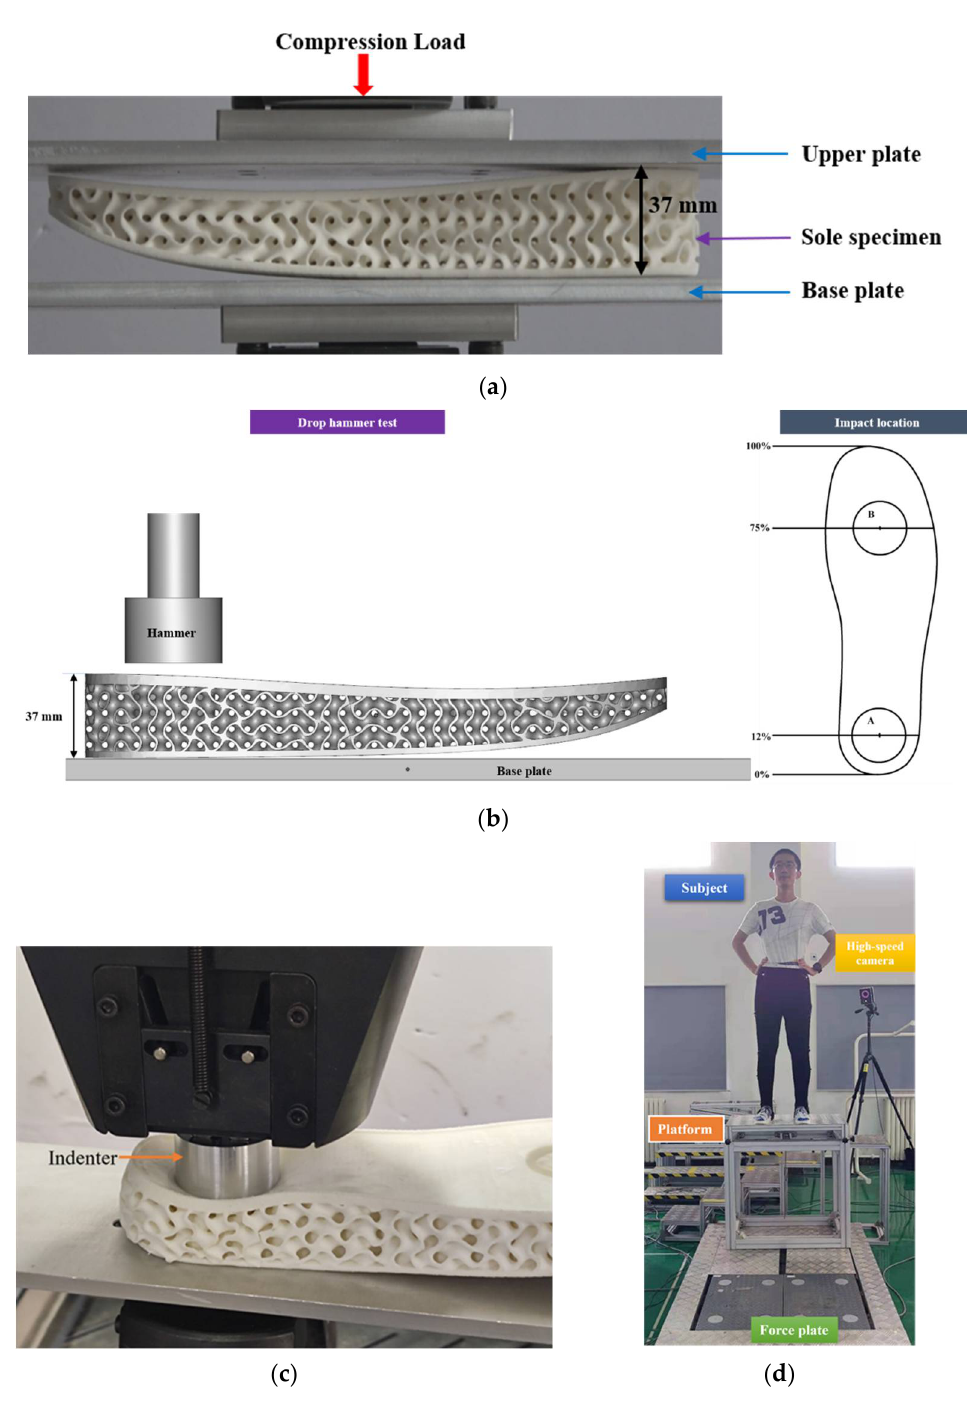
Figure 4. Experimental methods and facilities. ( a ) Quasi-static compression test; ( b ) drop hammer test; ( c ) quasi-static indenter compression test compared to drop hammer tests; ( d ) drop landing tests.